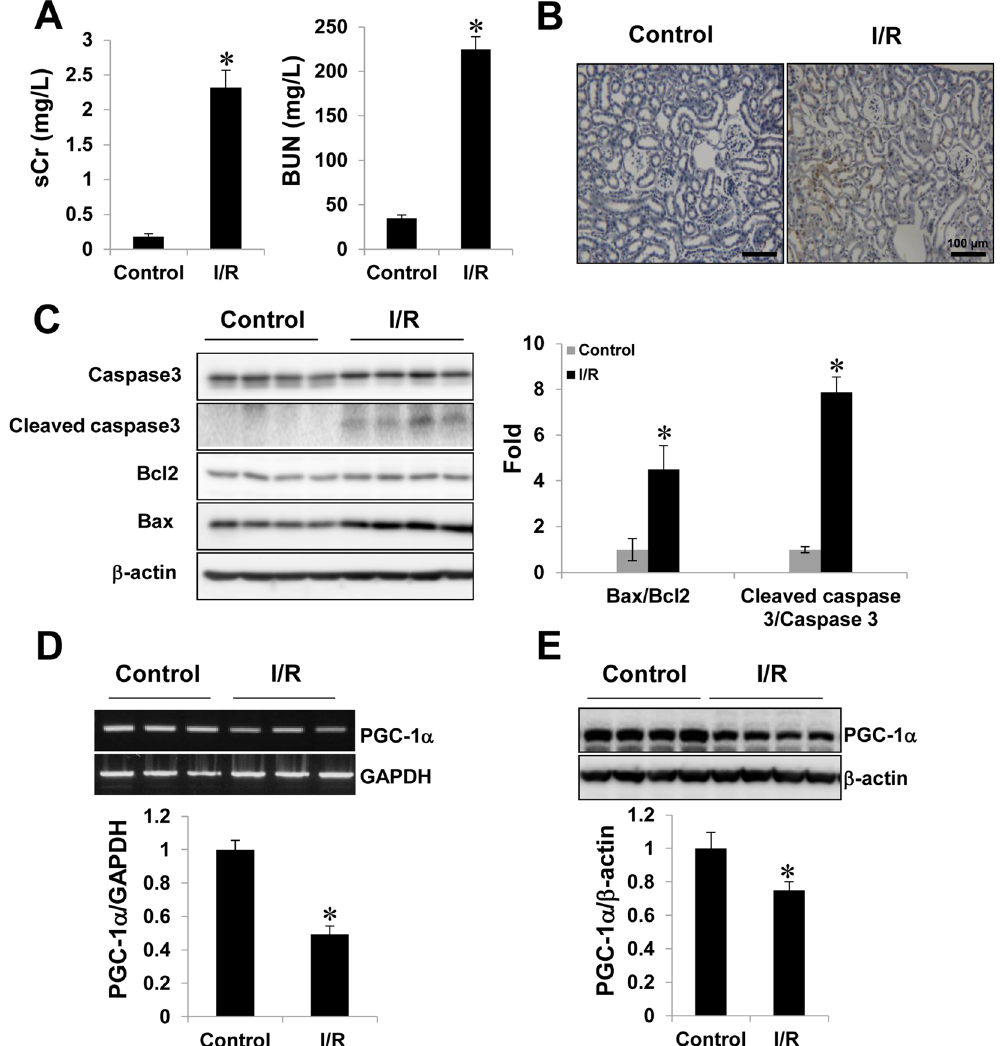
Figure 1. Downregulation of PGC-1 α in I/R-induced kidney injury. ( A ) Plasma creatinin and blood urea nitrogen (BUN) levels of control vs. I/R-induced kidney injury in mice. ( B ) Terminal deoxynucleotidyl transferase-mediated dUTP nick end-labeling (TUNEL) staining of the kidney. Magnification at x100, Bar = 100 μ m. ( C ) I/R-induced kidney injury was assessed by evaluating the expression of apoptotic proteins (ratio of Bax to Bcl2 and cleaved caspase 3 to caspase 3). ( D ) The mRNA expression of PGC-1 α in control mice vs. those that underwent I/R-induced kidney injury. ( E ) Protein expression of PGC-1 α in control mice vs. those that underwent I/R-induced kidney injury. The bar graph shows the indicated target expression measured by densitometry. GAPDH and β -actin levels were analyzed as internal controls. Full-length blots of each tested protein are reported in Supplementary Figure S1. * p < 0.05 control vs. I/R